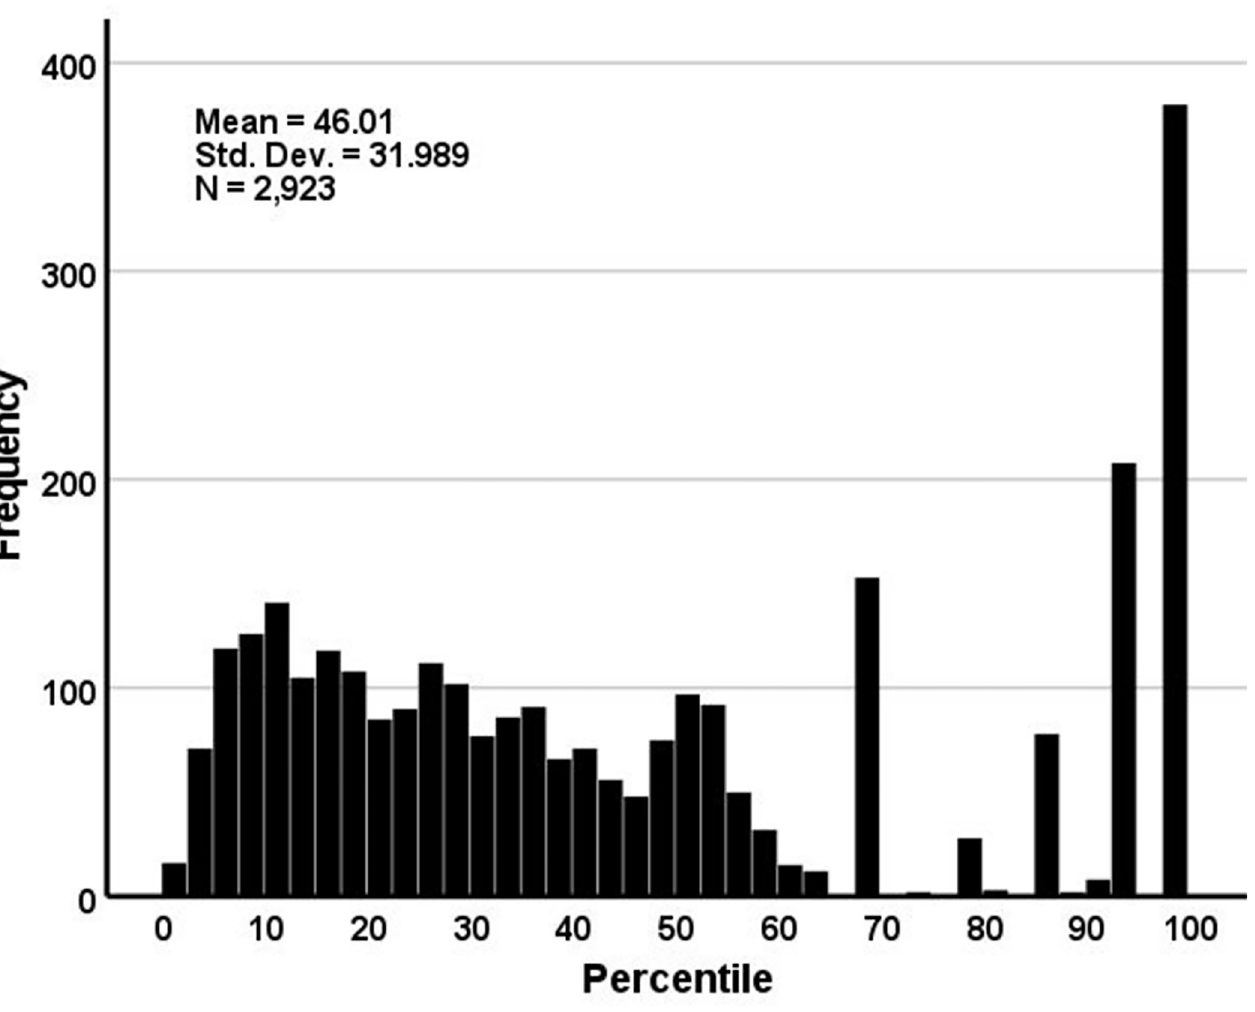
Fig 2. Distribution of virtual control cases’ assigned